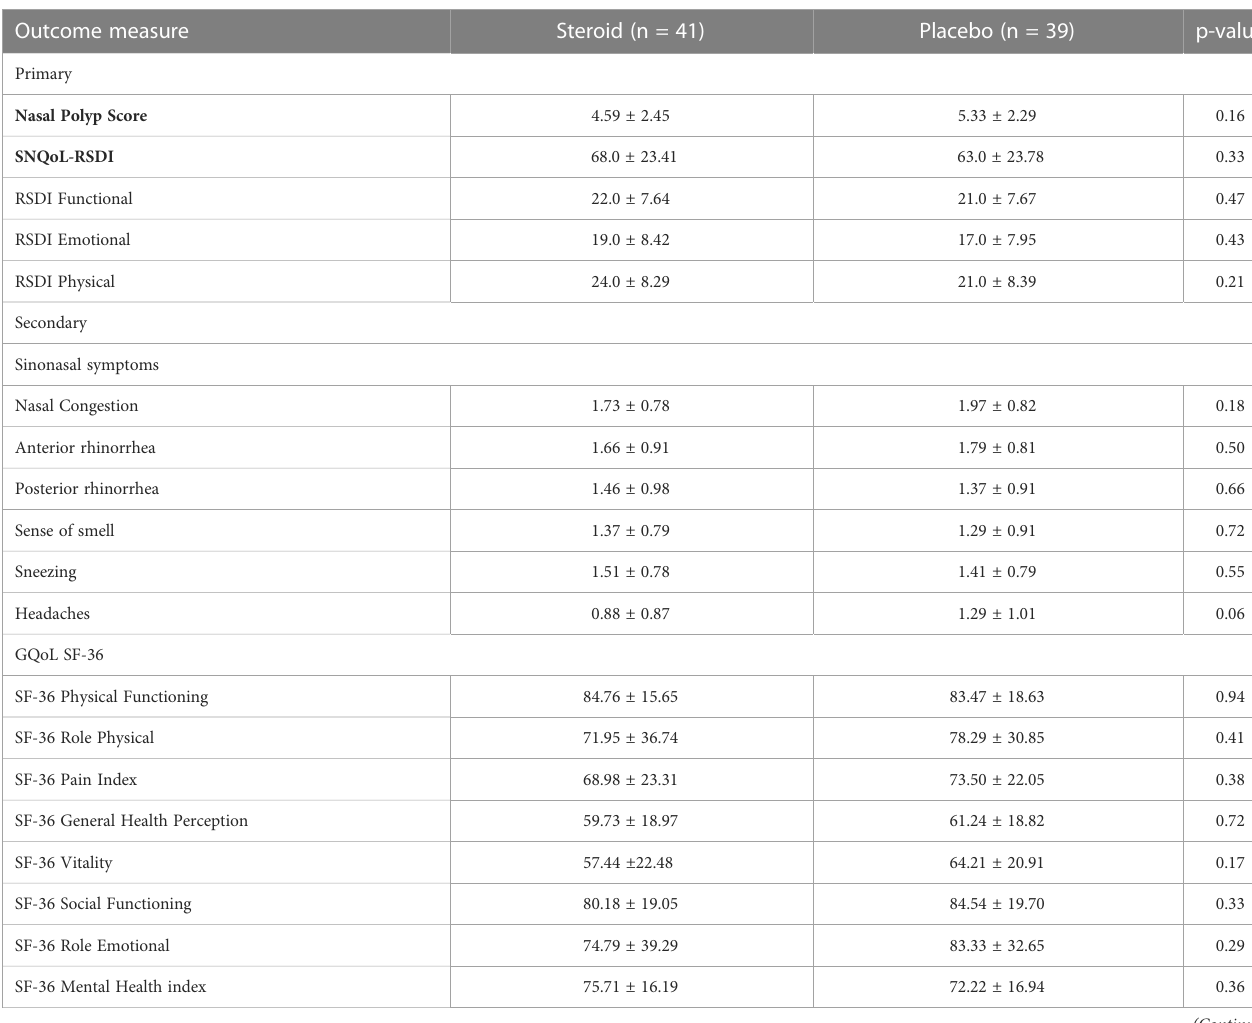
TABLE 2 Baseline testing for all primary and secondary outcome measures as well as for the Lund-Mackay score (intention-to-treat group, n=80). Outcome